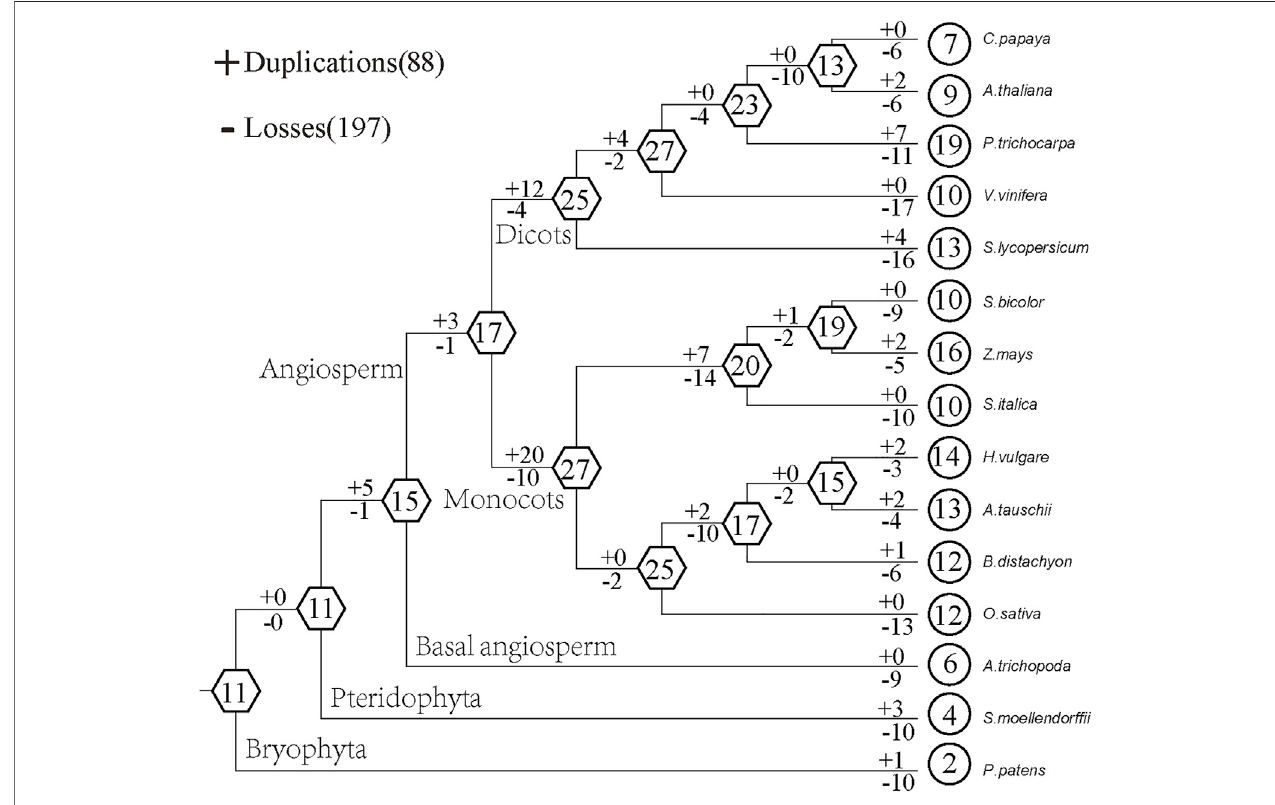
FIGURE 3 | Schematic diagram of gain and loss of GRF gene family in plants. The numbers in the hexagons and circles represent the number of GRF genes in ancestors and existing species, and the + and − signs represent the gain and loss of genes, respectively.